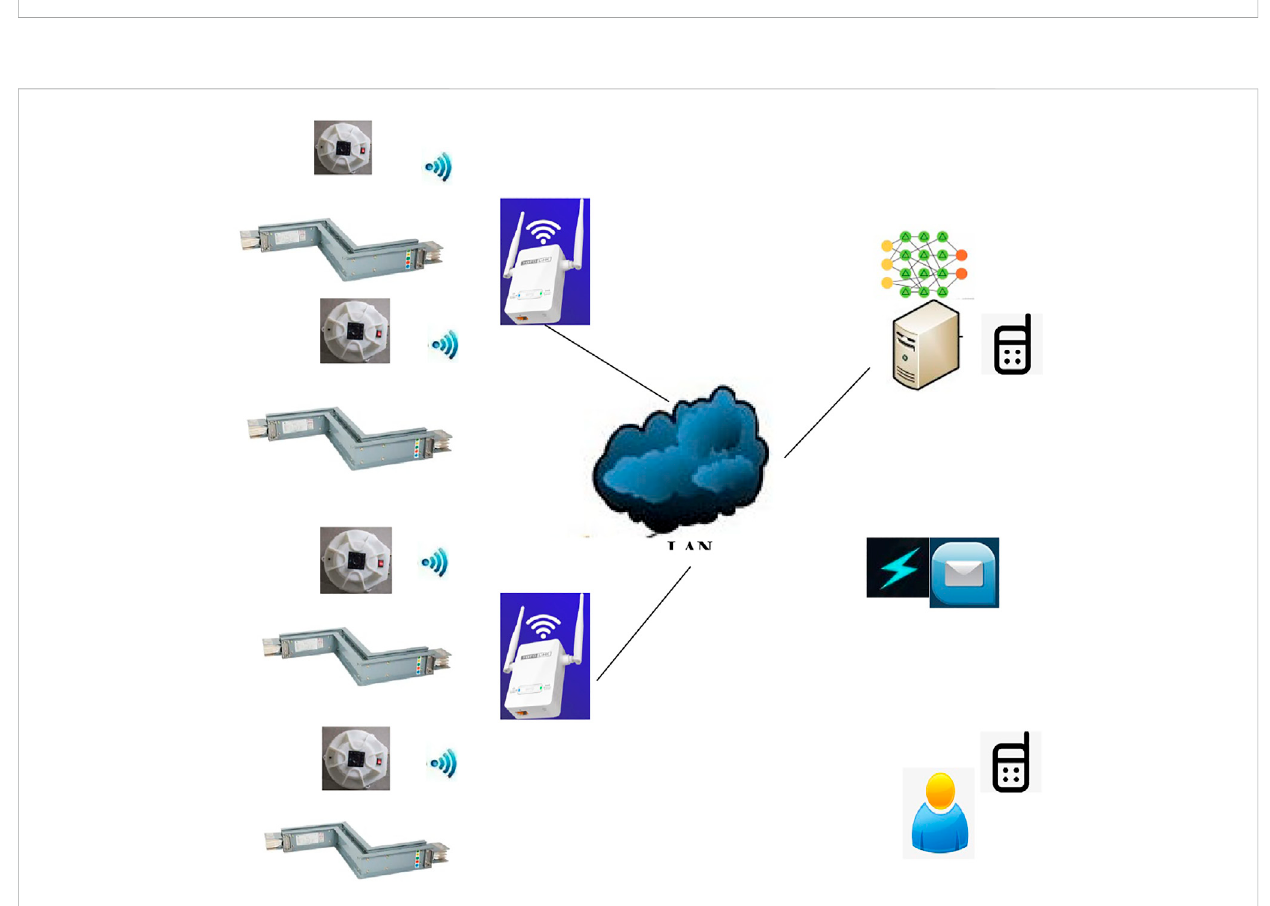
FIGURE 8 Overheating alarm system for